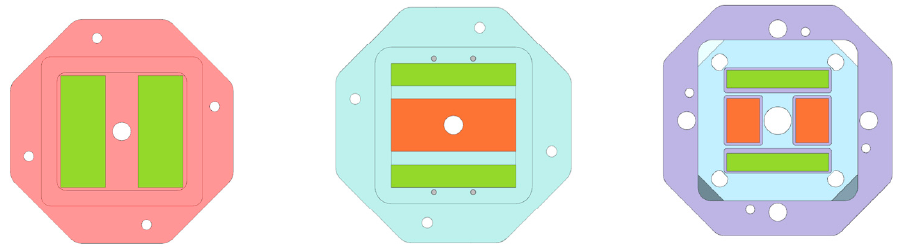
Figure 3. Yellow represents the test mass; green represents the sensing/driving electrode; brown represents the excitation ‐ injection electrode.